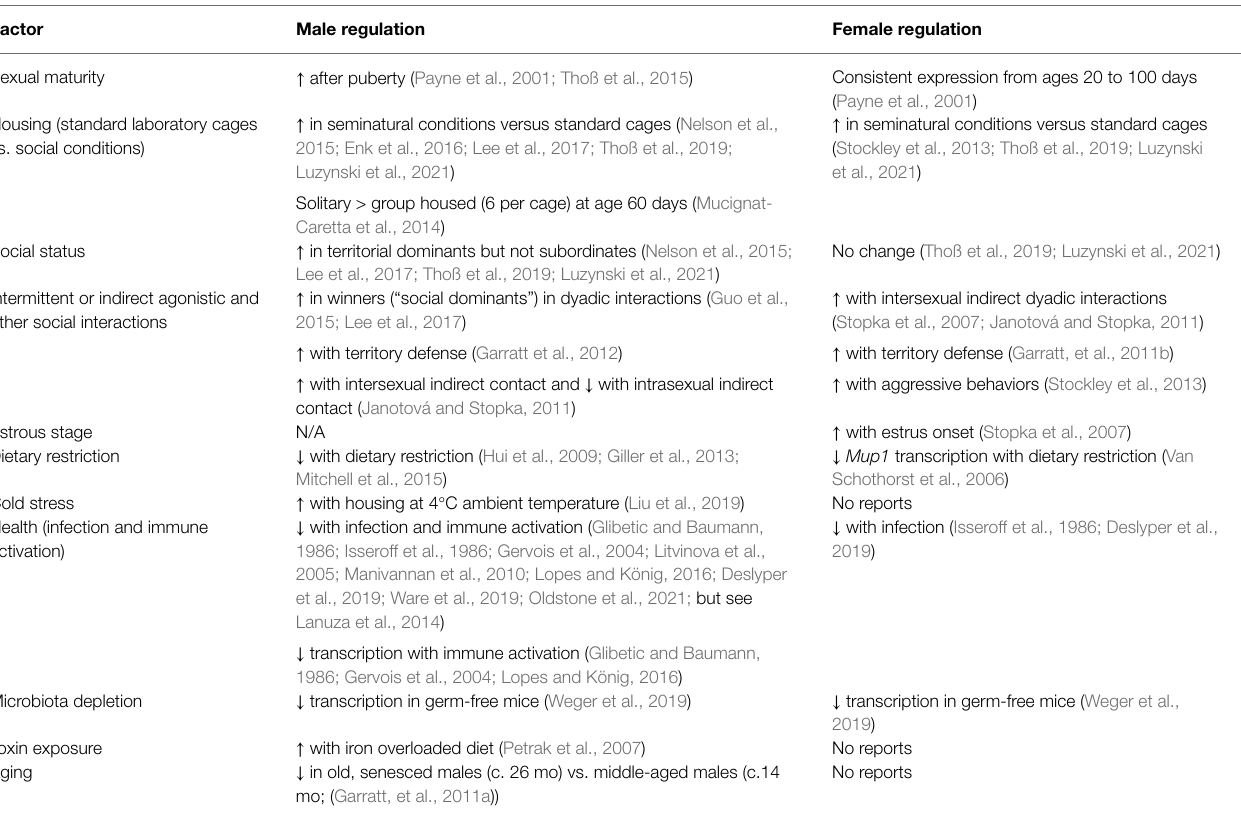
TABLE 1 | Factors affecting MUP